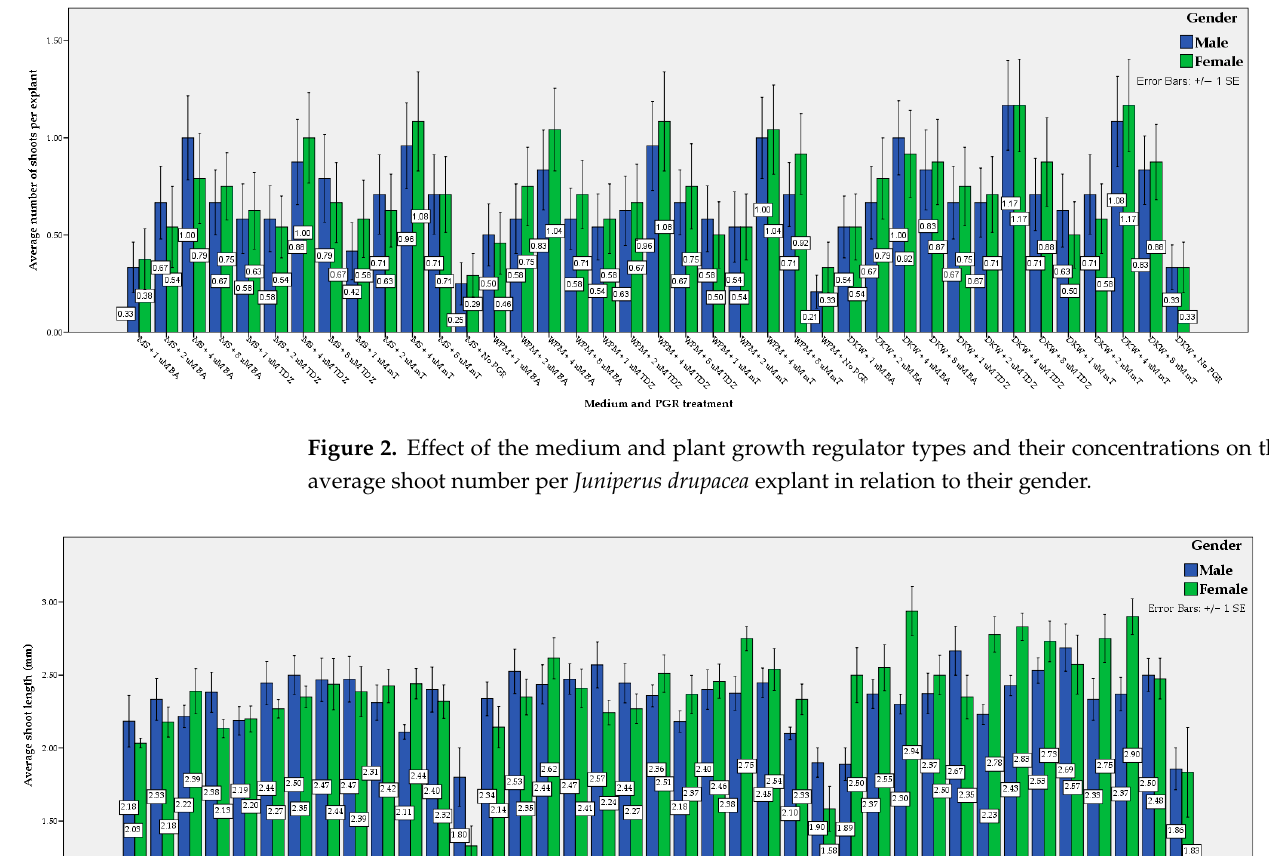
Maximum average shoot length per explant in the female explants was achieved